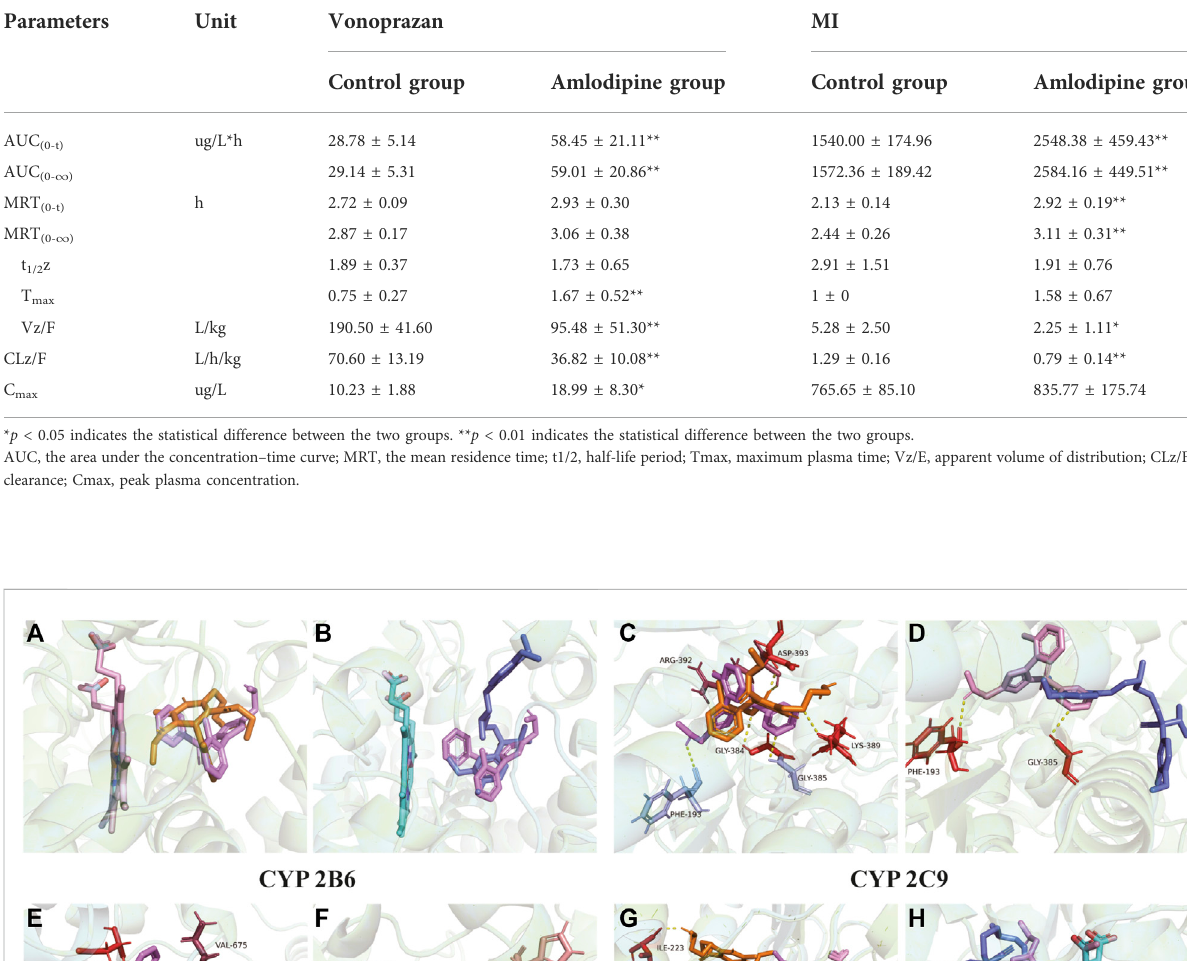
TABLE 2 Pharmacokinetic parameters of vonoprazan and MI (mean ± SD, n = 6). Parameters